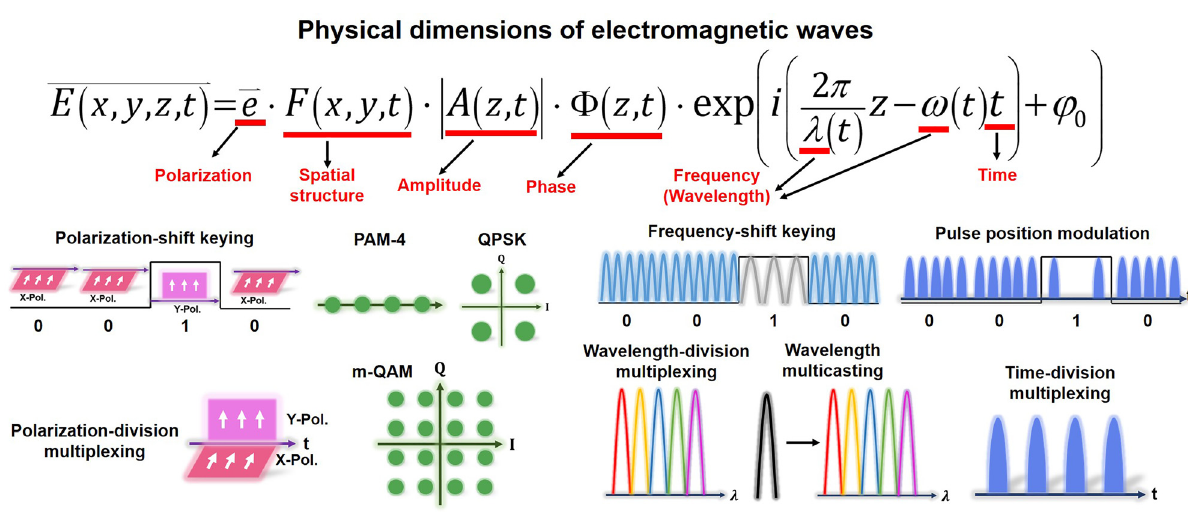
Figure 3: Illustration of physical dimensions/degrees of freedom of electromagnetic waves (frequency/wavelength, amplitude, phase, polarization, time, spatial structure).